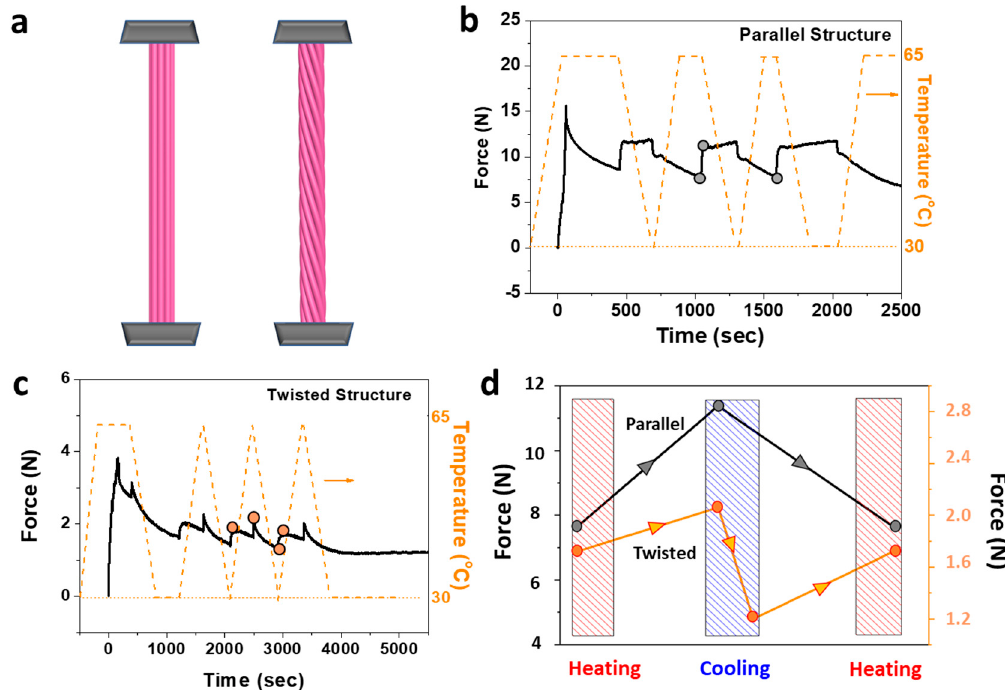
Figure 1. ( a ) Raw wool fibers in the parallel and twisted structures. Isometric contraction test of wool fibers in ( b ) parallel and ( c ) twisted structure responding to the stimuli of temperature. ( d ) Evaluation of force change in two structures: adopted data were acquired from the marked points as shown in ( b ) grey circles and ( c ) orange circles.